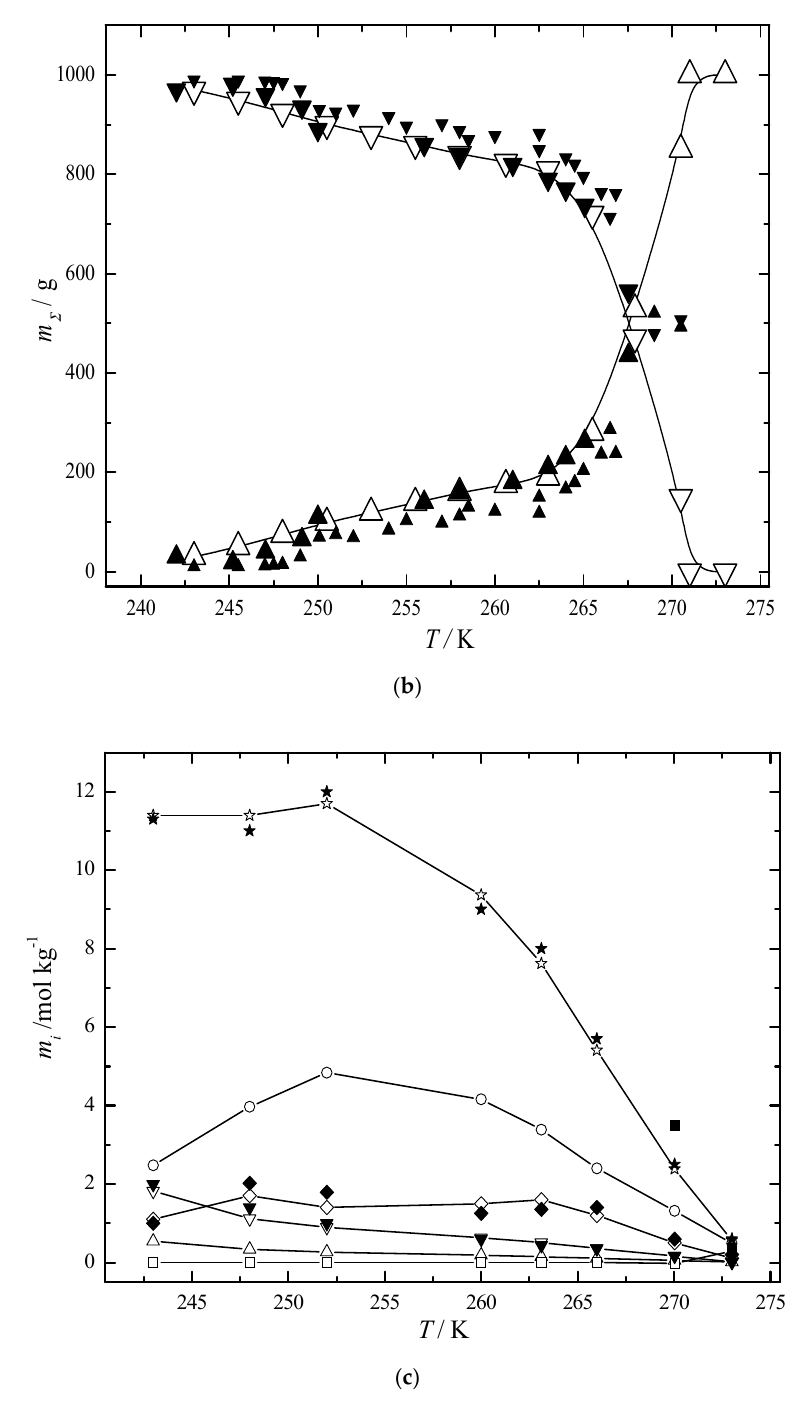
Figure 4. Open crystallization curves in the Na + , K + , Ca 2+ , Mg 2+ //Cl − , SO 42 − -H 2 O system during freezing from 273 to 243 K. Temperature dependences of the solid phase masses ( a ); total mass of the system (liquid and solid phases) ( b ); and composition of liquid phase ( c ). m i , molality of solution; m ( s ) , mass of the solid phase; m ( l ) , mass of the liquid phase; m ∑ , total mass of the system (liquid and solid phases) open points, calculation; solid points, experimental data. Initial composition of solution (mol · kg − 1 ): m(Na + ) = 0.485, m(K + ) = 0.010, m(Ca 2+ ) = 0.011, m(Mg 2+ ) = 0.056, m(Cl − ) = 0.565 m(SO 4 2 − ) = 0.029; initial solution mass M ( l ) 0 = 1000 g. ( a ) H 2 O (ice), ○ , m (s) ·0.02; Na 2 SO 4 ·10H 2 O, △ ; CaSO 4 ·2H 2 O, ▽ ,